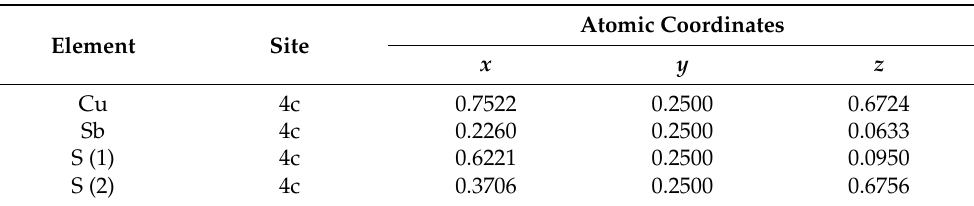
Table 2. Atomic coordinates ( x , y and z ) determined by the Rietveld refinement of the constituent elements of Cu, Sb and S of the heat-treated CuSbS 2 powders.